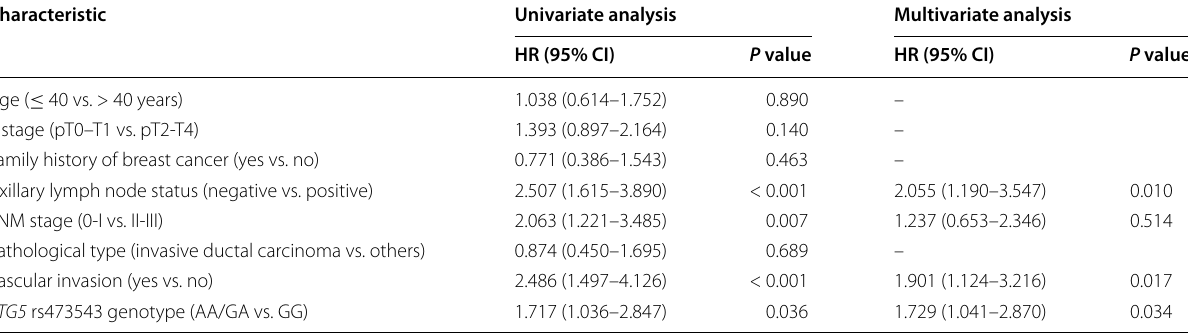
Table 4 Univariate and multivariate analyses of prognostic factors for DFS of TNBC